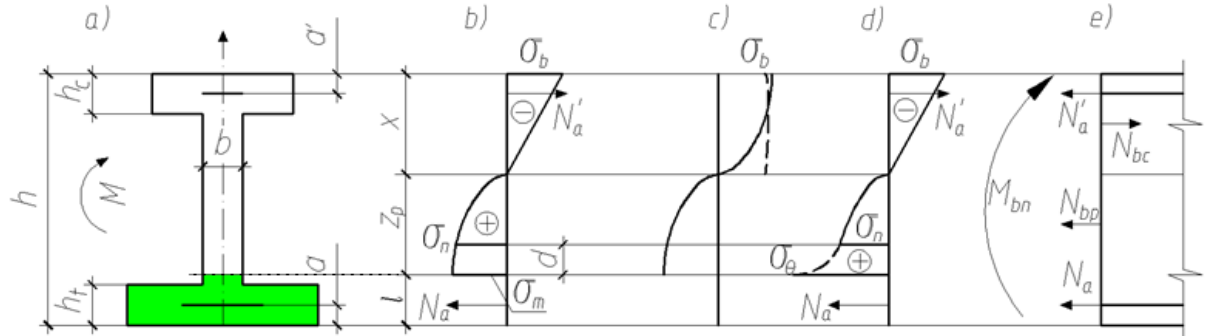
Figure 1. Scheme of stress distribution in the cross-section of a bending beam with the crack length l and the height of the compression zone x : ( a ) Cross-section of the beam; ( b , c ) Epures of nominal stresses in the beam section; ( d ) Epures of stress at the crack tip; ( e ) Forces acting in the section. The green color marks the crack zone.